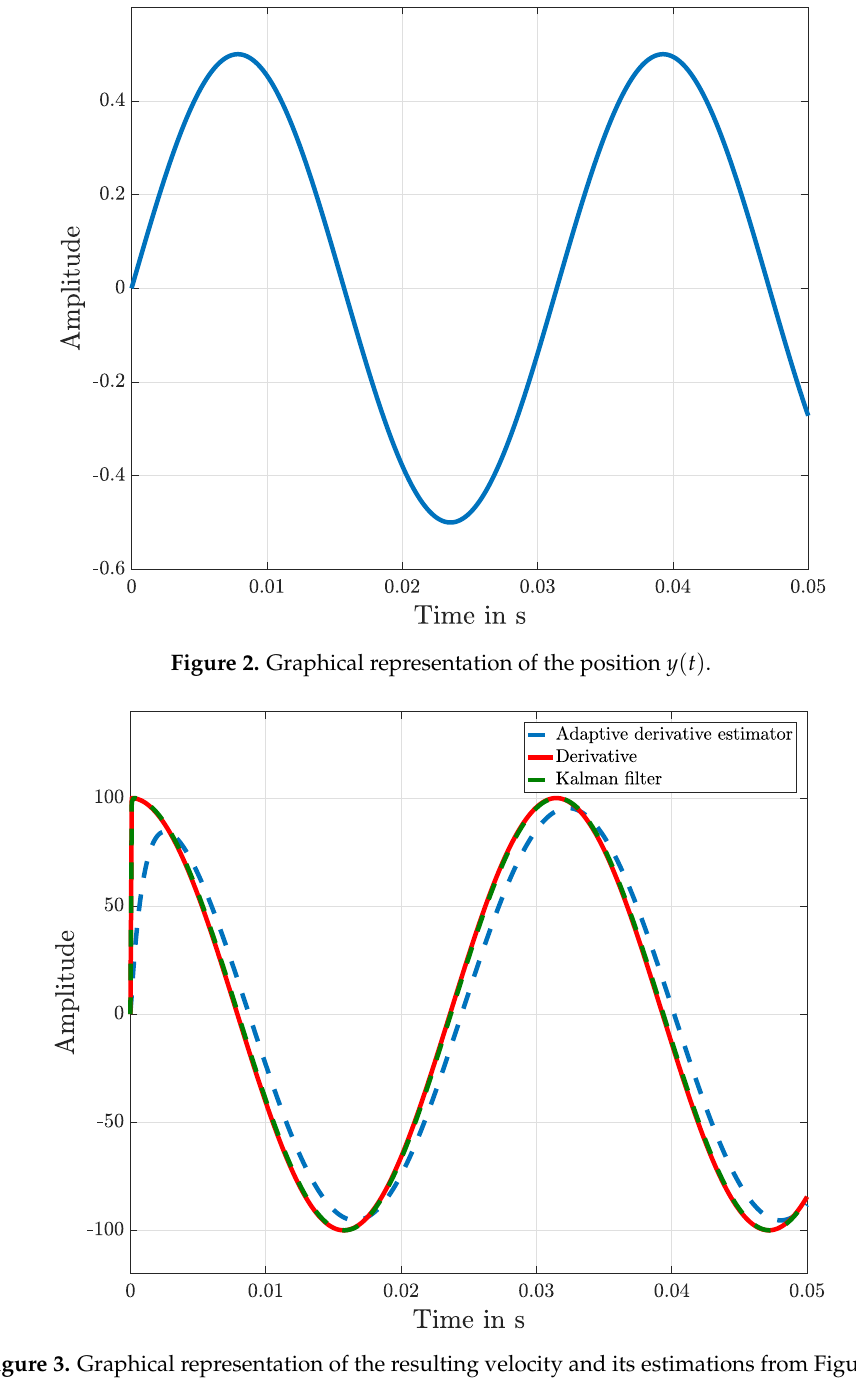
Figure 3. Graphical representation of the resulting velocity and its estimations from Figure